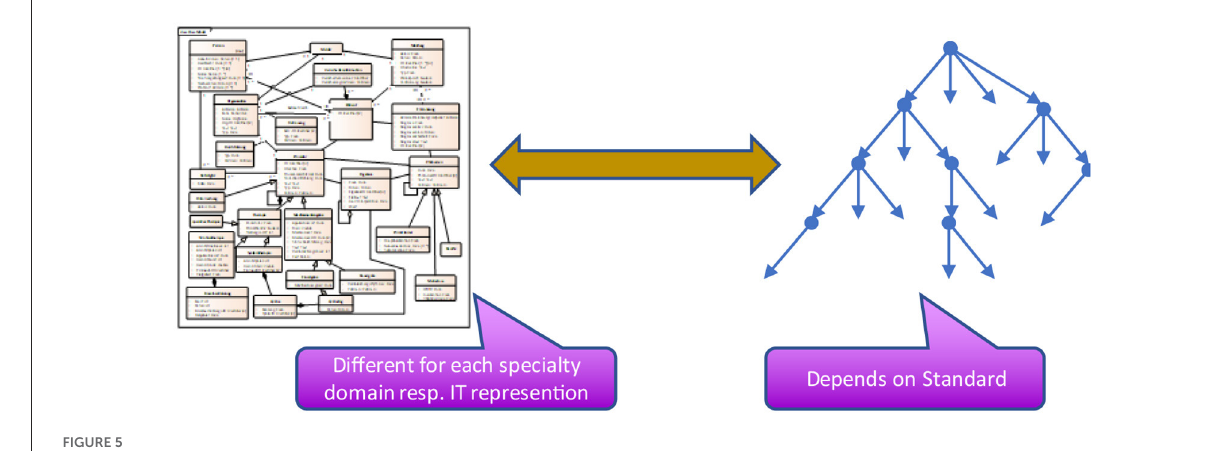
FIGURE5 Projection to standards.